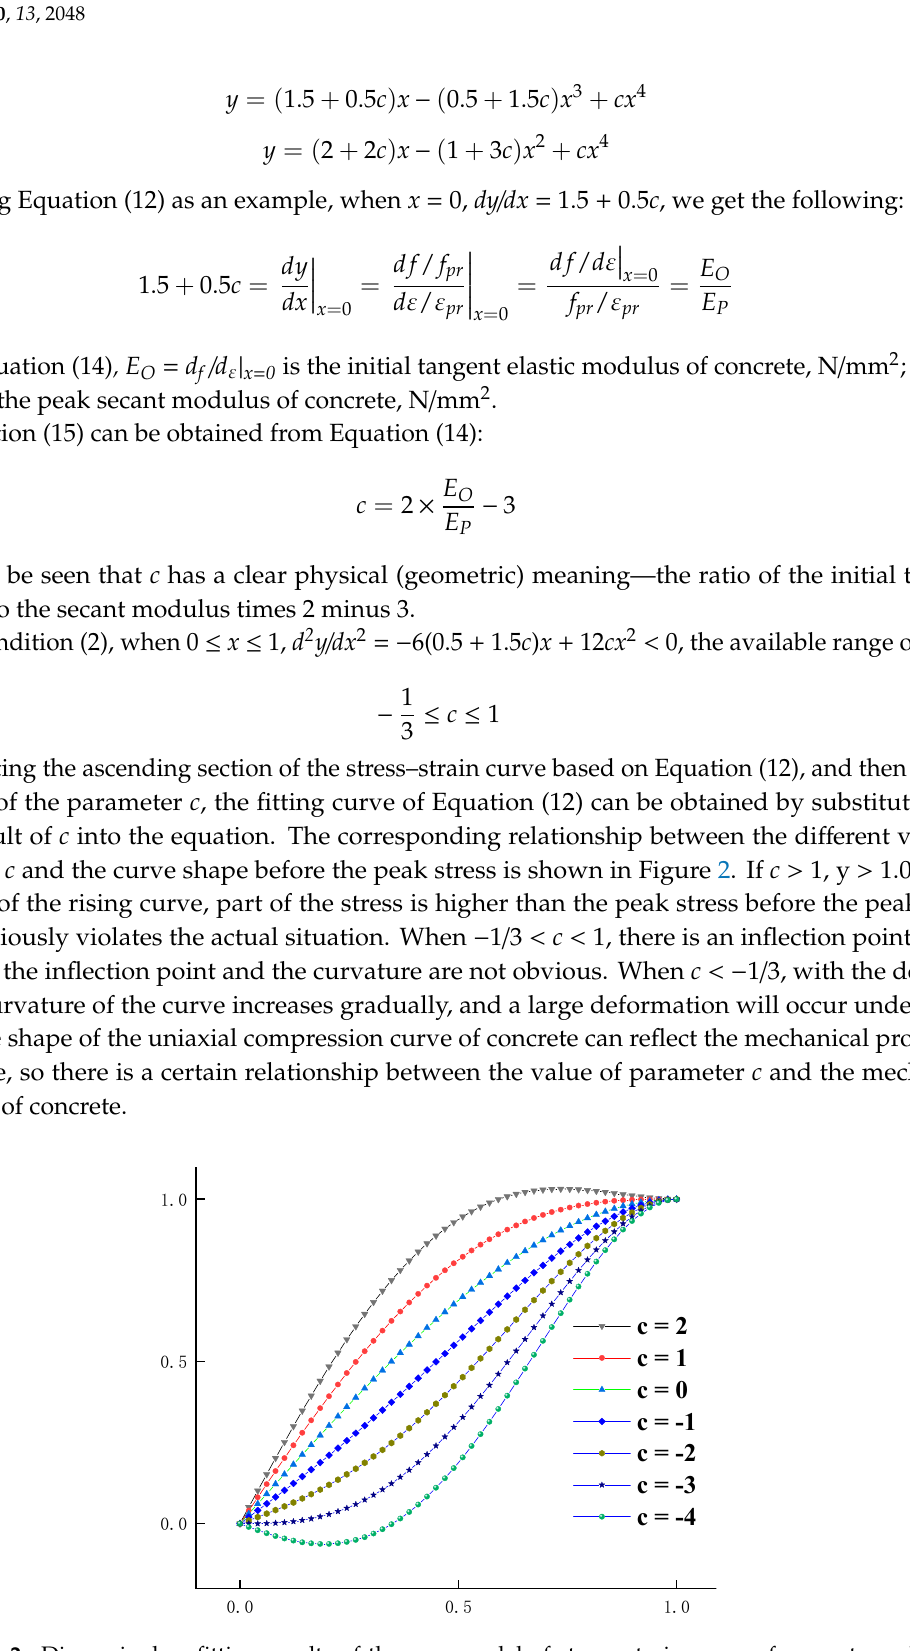
Figure 2. Dimensionless fitting results of the new model of stress–strain curve of concrete under uniaxial compression.